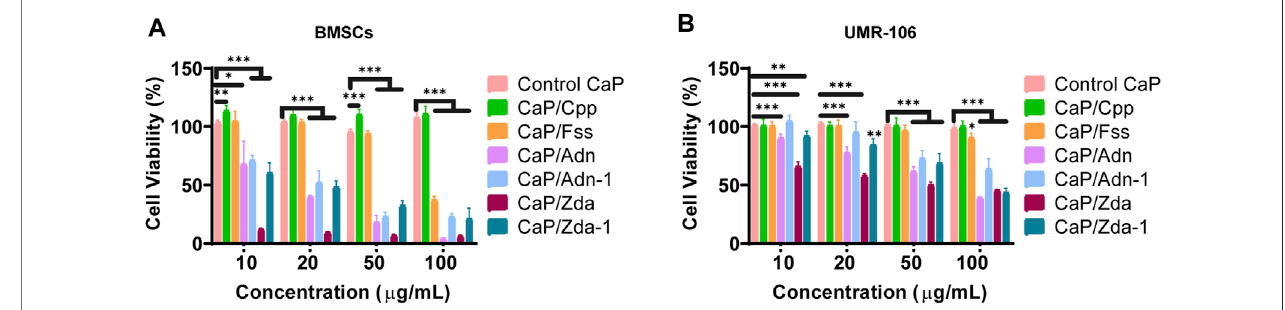
FIGURE 6 | Cell viability of BMSCs (A) and UMR-106 (B) cells co-cultured with different CaPs at various concentrations for 48